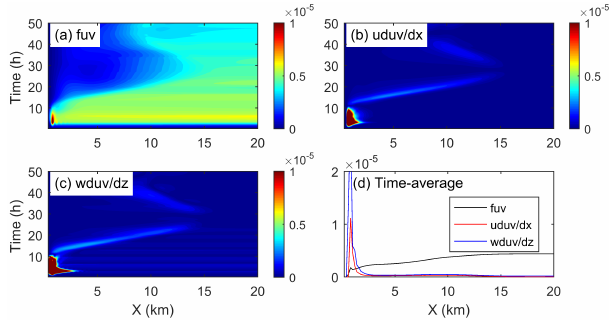
Figure 6. Variation of depth-mean inertial and non-linear terms (ms − 2 ) . The inertial term (a) is calculated as | f (u + iv) | , the hor- izontal non-linear term (b) is | u(∂u/∂x + i∂v/∂x) | , and the verti- cal non-linear term (c) is | w(∂u/∂z + i∂v/∂z) | . (d) Time-averaged value for the first